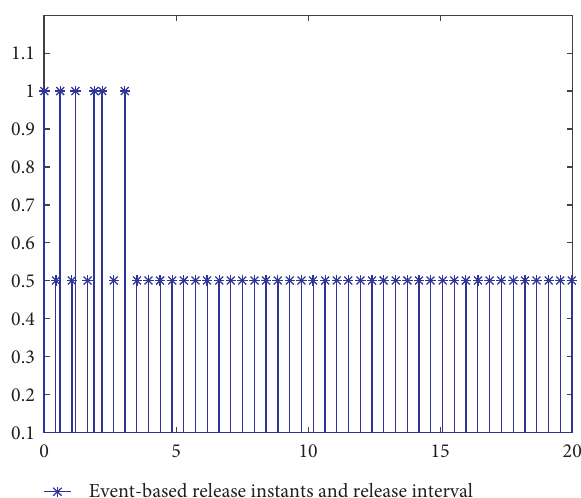
Figure 4: The dynamics of event-triggered mechanism.